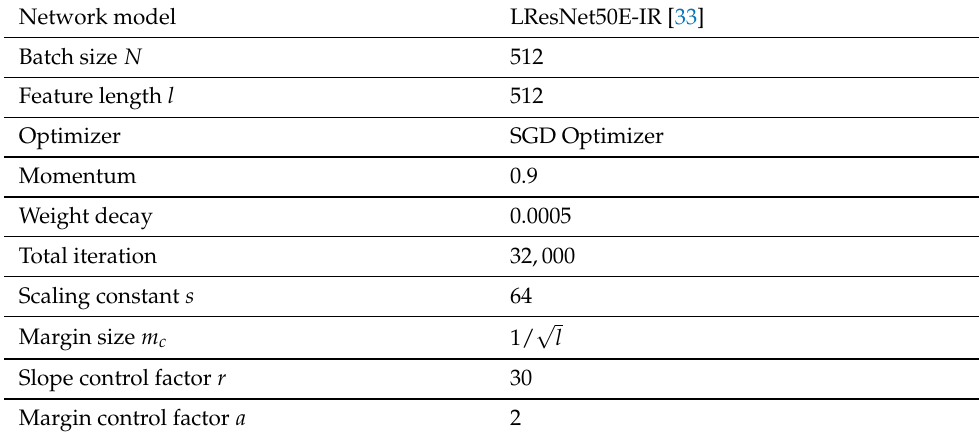
Table 2. Training Setting and Hyperparamters.